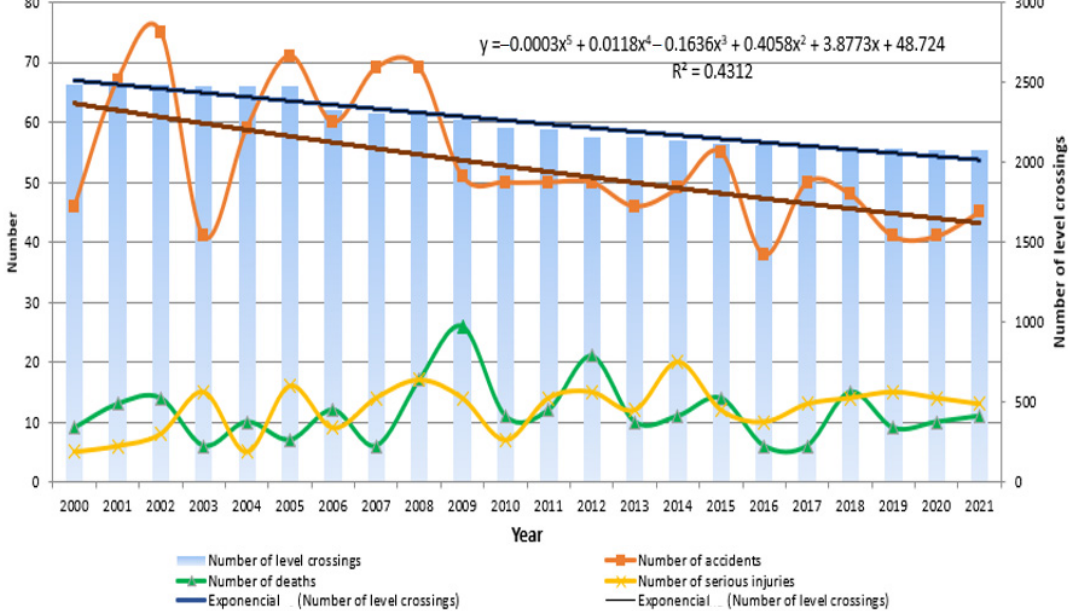
Figure 1. Development of rail crossing accidents between 2000 and 2021 showing a trend. Exponential curve for rail crossing development and for number of accidents.